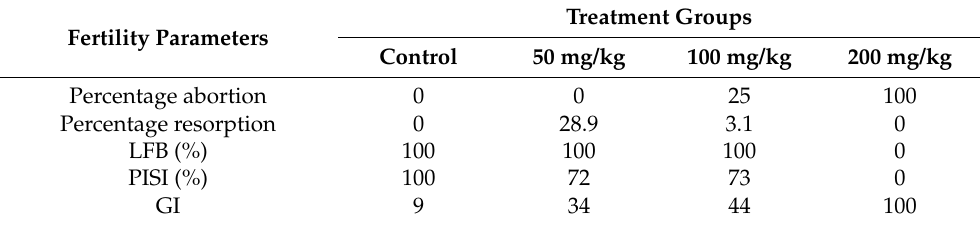
Table 4. Group fertility parameters of adult female albino rats fed graded doses of methanolic ex- tract of Azadirachta indica.